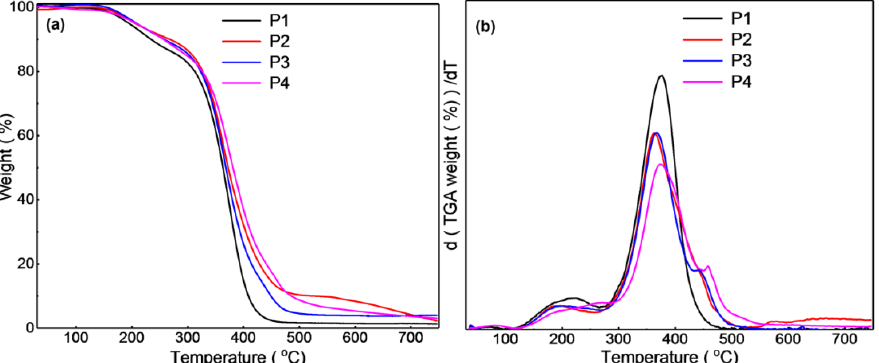
Figure 7. Curves ( a ) and DTGA curves ( b ) for the four films. Figure 6. curves ( a ) and DTGA curves ( b ) for the four films. Table 5. Thermal properties of the four films. Table 5. Thermal properties of the four films.